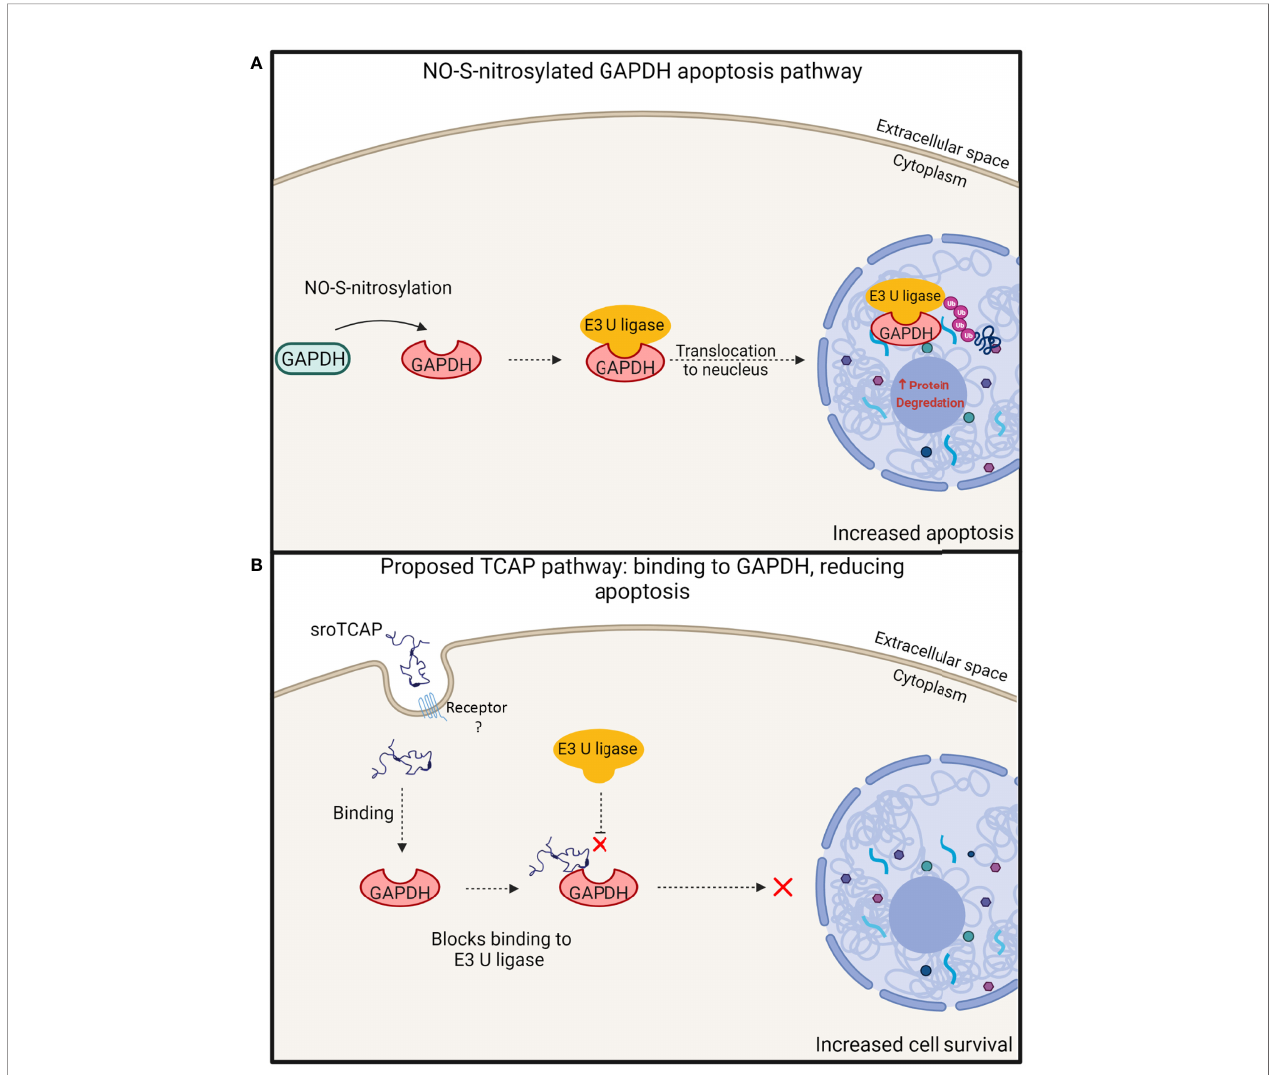
FIGURE 10 | Proposed model of TCAP and GAPDH interaction, leading to increased cell survival during stress. (A) Under oxidative conditions, GAPDH undergoes NO-S-nitrosylation, where it can then bind to E3 ubiquitin ligase. This protein complex transits to the nucleus, degrading nuclear proteins, resulting in apoptosis [modi fi ed from Hara et al. (51)]. (B) A proposed TCAP interaction with GAPDH leading to the inhibition of GAPDH binding with E3 ubiquitin ligase, thus preventing its downstream apoptotic actions. The inhibition of this pathway supports increased cell survival under stress. Created with